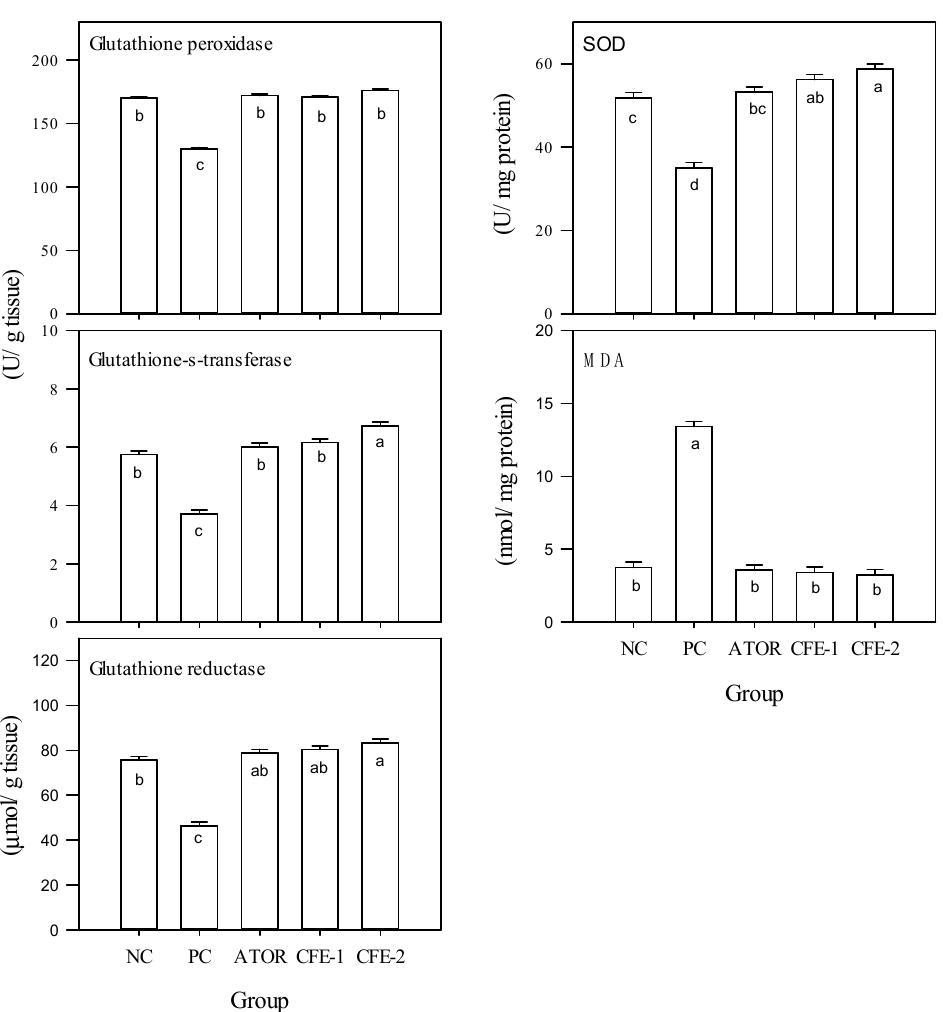
Figure 2. Oxidative stress parameters in liver of male albino rats, i.e., glutathione peroxidase, glutathione-s-transferase, glutathione reductase, superoxide dismutase (SOD), and malondialdehyde (MDA) after 9 weeks. Group 1 received a normal diet (Negative control: NC). Groups 2–5 received a high-fat diet, where group 2 did not receive any further treatment (Positive control: PC). Group 3 was treated with atorvastatin (10 mg kg − 1 ), while groups 4 and 5 were treated with Lactobacillus paracasei postbiotic (CFE-1 and CFE-2; at 100 and 200 mg kg − 1 , respectively). Values are presented as mean ± SD ( n = 8). Mean values within the same histogram with different superscripts letters are significantly different ( p < 0.05). Forty animals were divided into five groups (8 animals each). Postbiotic is the cell-free extract (CFE).